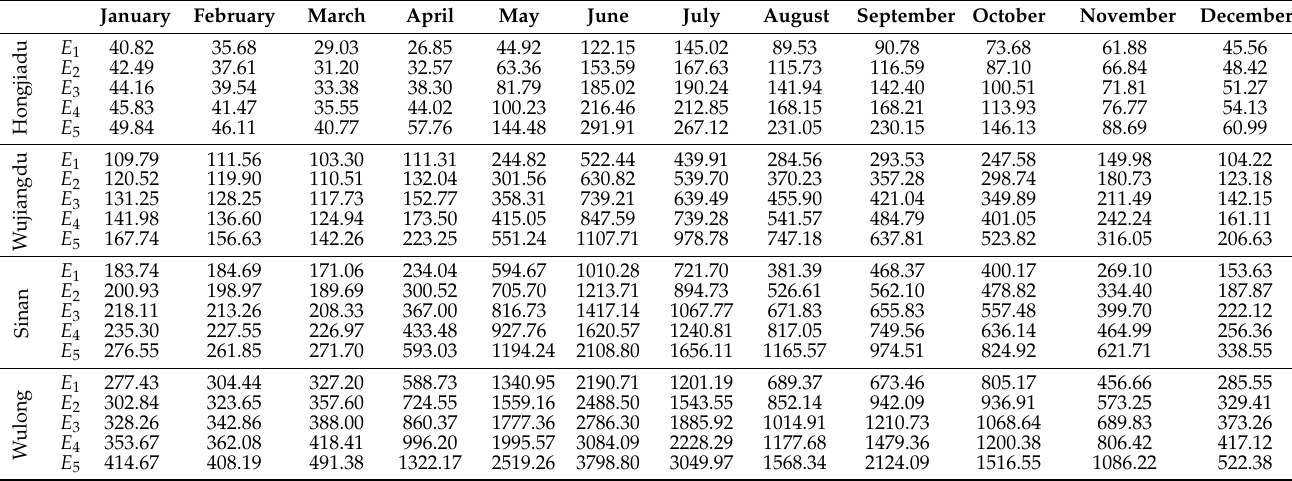
Table 3. Environmental flows of Wujiang River calculated by the T-FDC method.